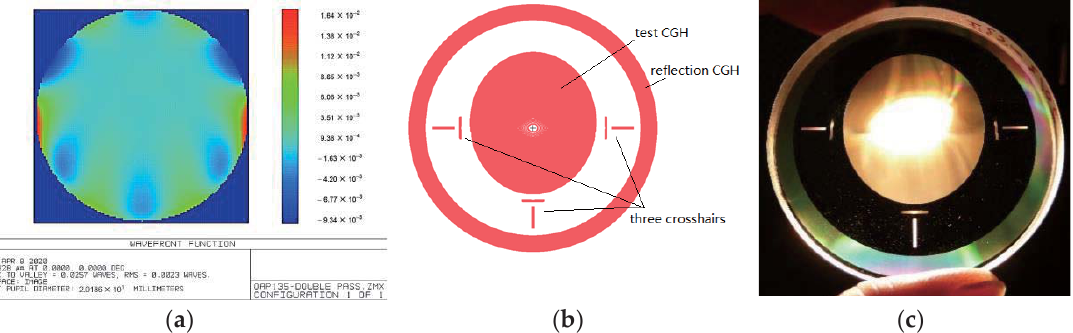
Figure 6. The geometry parameters of measuring this OAP with a single CGH.